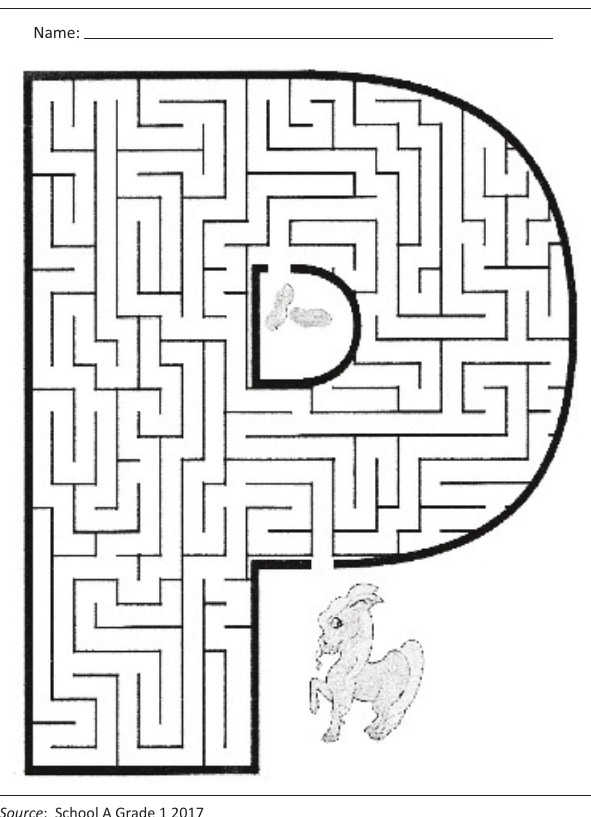
FIGURE 1: Worksheet prepared for Grade 1 learners to practise forming the letter ‘p’.